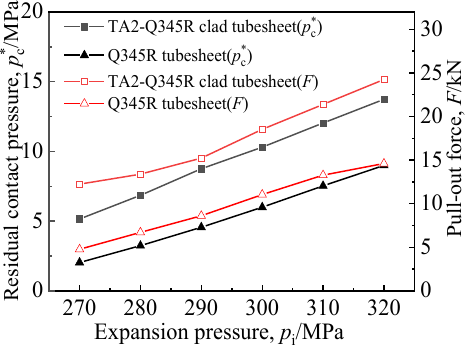
Figure 5. Tight expansion joints performance of two kinds of tubesheets.